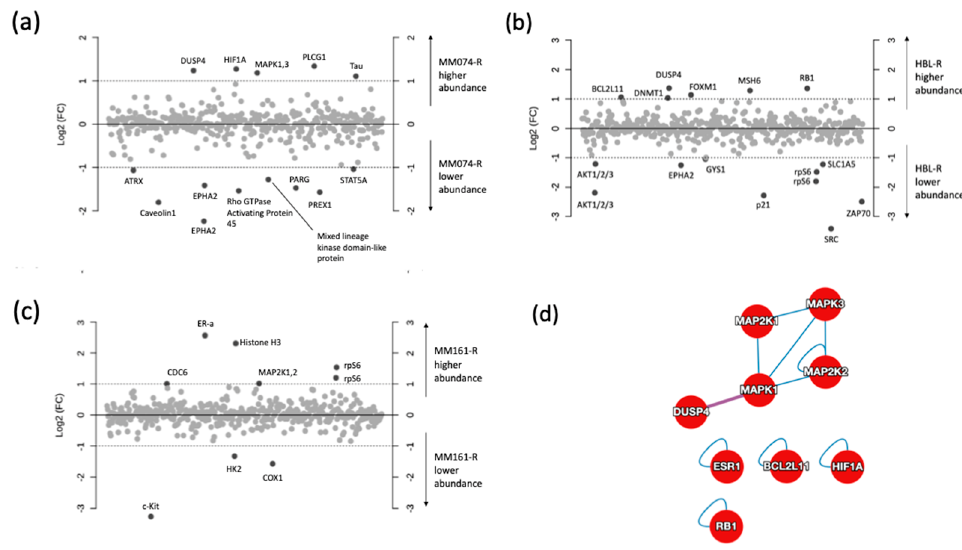
(Table S4), enabling the fold-change (FC) analysis of this panel of protein-relative intensities between the sensitive and resistance